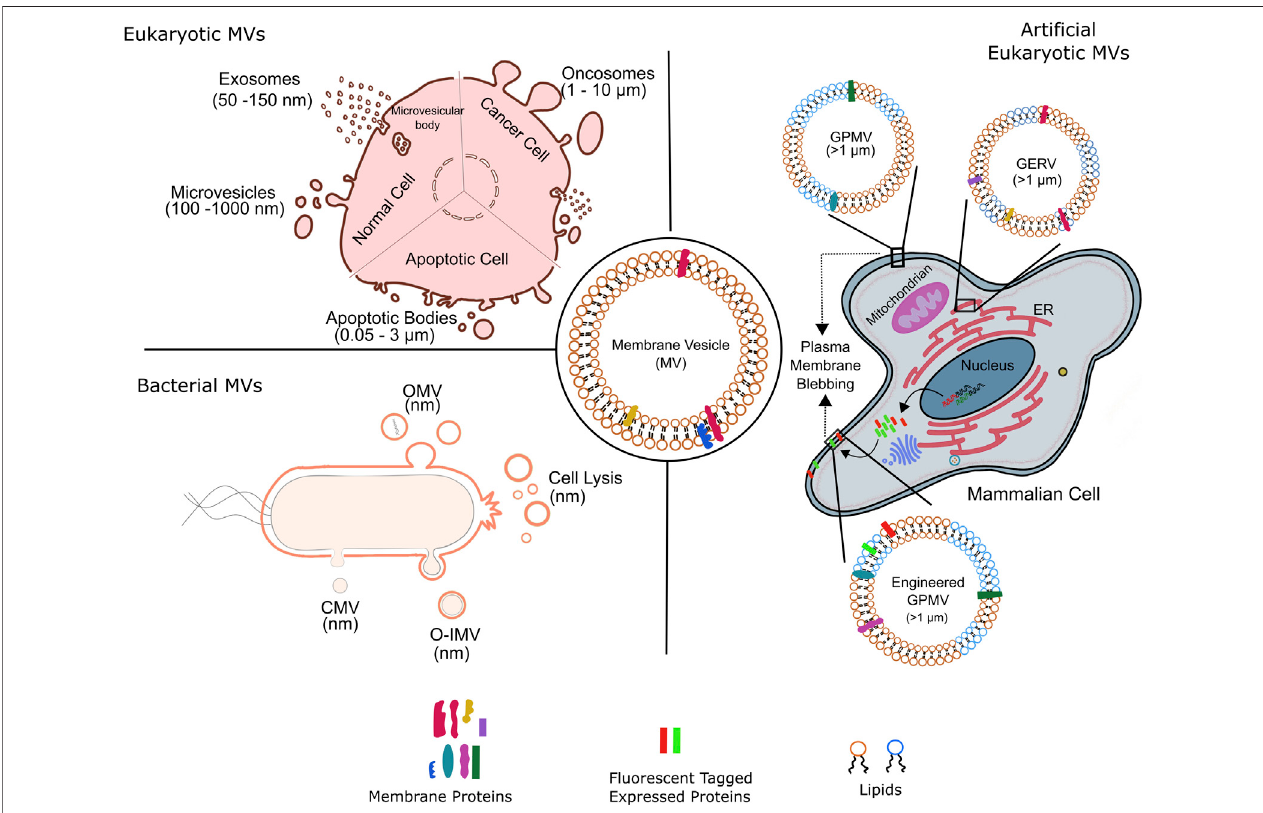
FIGURE 1 | Membrane vesicles of variable sizes and origin. Schematic representation of various kinds of natural membrane vesicles from eukaryotic and bacterial cells.ofthekindsofvesiclesobtainedfromdifferentcelltypes.Arti fi cialmembranevesicles,giantplasmamembranevesicle(GPMV),synthesizedfromeukaryoticcellsby chemical blebbing from plasma membranes of wild type or genetically modi fi ed cells. The exogenously expressed fl uorescent tagged proteins in genetically modi fi ed cells are incorporated into the cell plasma membrane before GPMVs formation, forming the so-called engineered GPMVs. Giant Endoplasmic Reticulum Vesicles (GERs)representmembranevesiclesderivedfromendoplasmicreticulum(ER).OMV,outermembranevesicle;CMV,cytoplasmicmembranevesicle;O-IMV,outerinner membrane vesicle; GPMV, giant plasma membrane vesicle and GERV, Giant endoplasmic reticulum